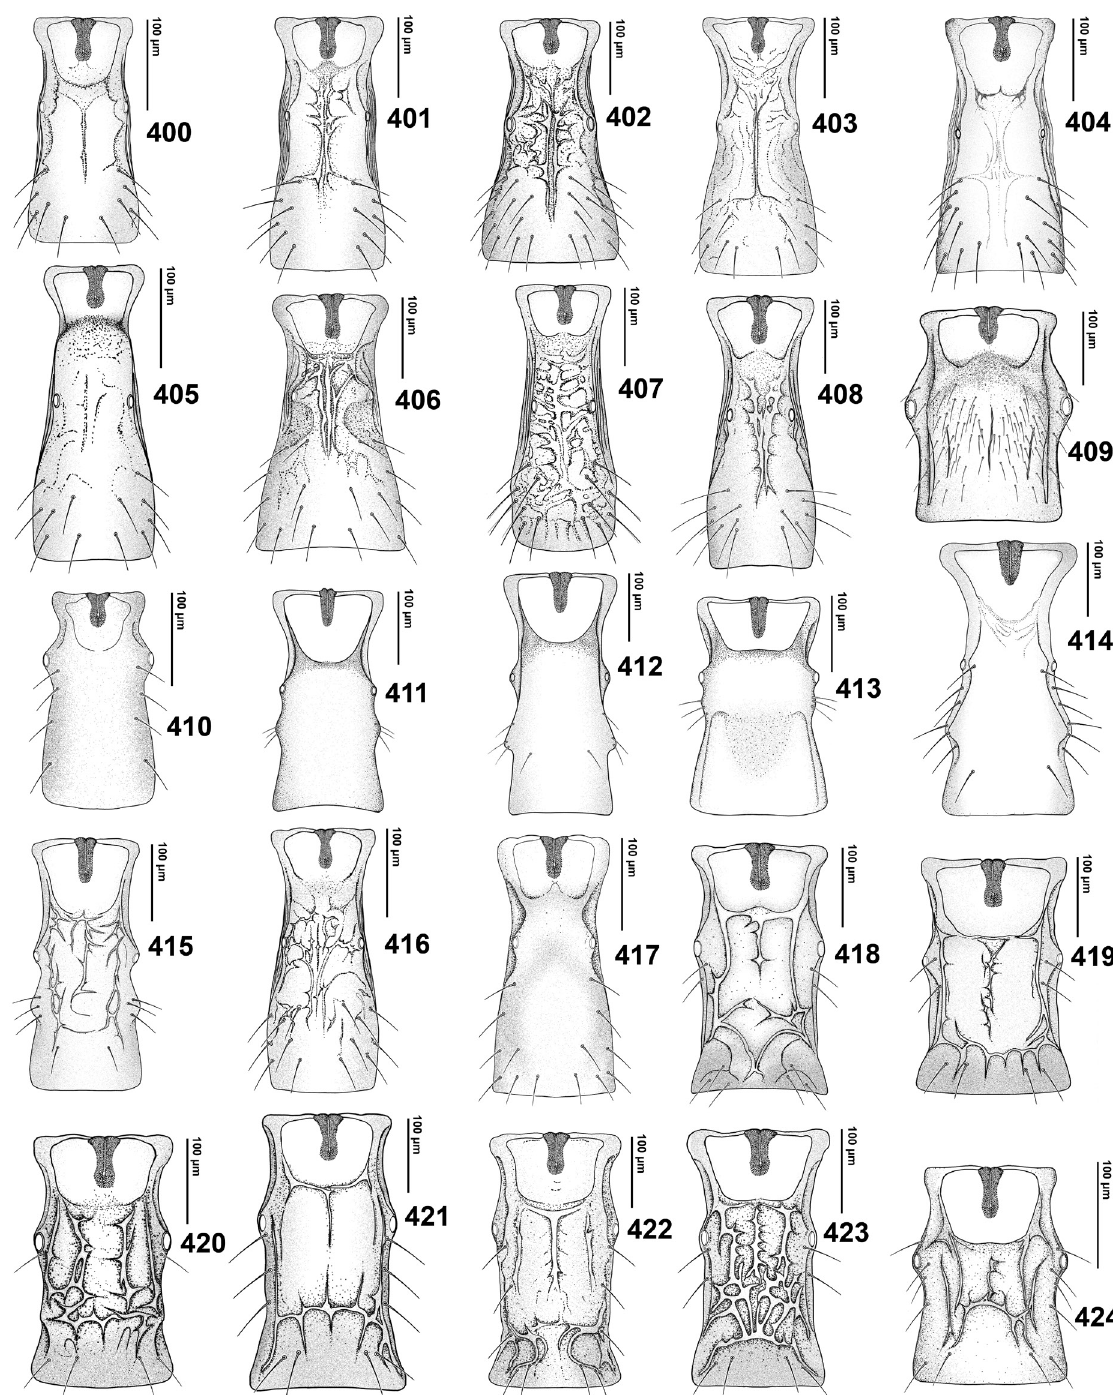
Figs 400–424. Dorsal aspect of petiole (♀): 400 . Aphidius salicis . 401 . Aphidius setiger . 402 . Aphidius smithi . 403 . Aphidius sonchi . 404 . Aphidius stigmaticus . 405 . Aphidius transcaspicus . 406 . Aphidius uroleuci . 407 . Aphidius urticae . 408 . Aphidius uzbekistanicus . 409 . Areopraon lepelleyi . 410 . Betuloxys hortorum . 411 . Binodoxys acalephae . 412 . Binodoxys angelicae . 413 . Binodoxys brevicornis . 414 . Binodoxys centaureae . 415 . Binodoxys heraclei . 416 . Diaeretiella rapae . 417 . Diaeretus leucopterus . 418 . Ephedrus cerasicola . 419 . Ephedrus chaitophori . 420 . Ephedrus helleni . 421 . Ephedrus lacertosus . 422 . Ephedrus nacheri . 423 . Ephedrus niger . 424 . Ephedrus persicae